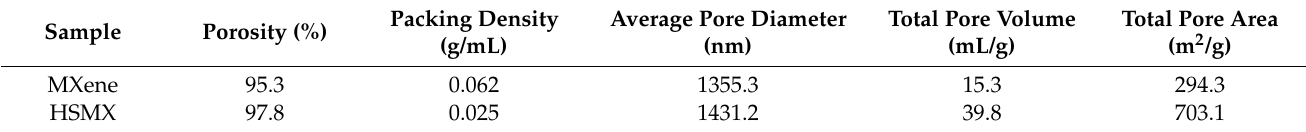
Table 2. Comparison of MIP parameters of MXene and